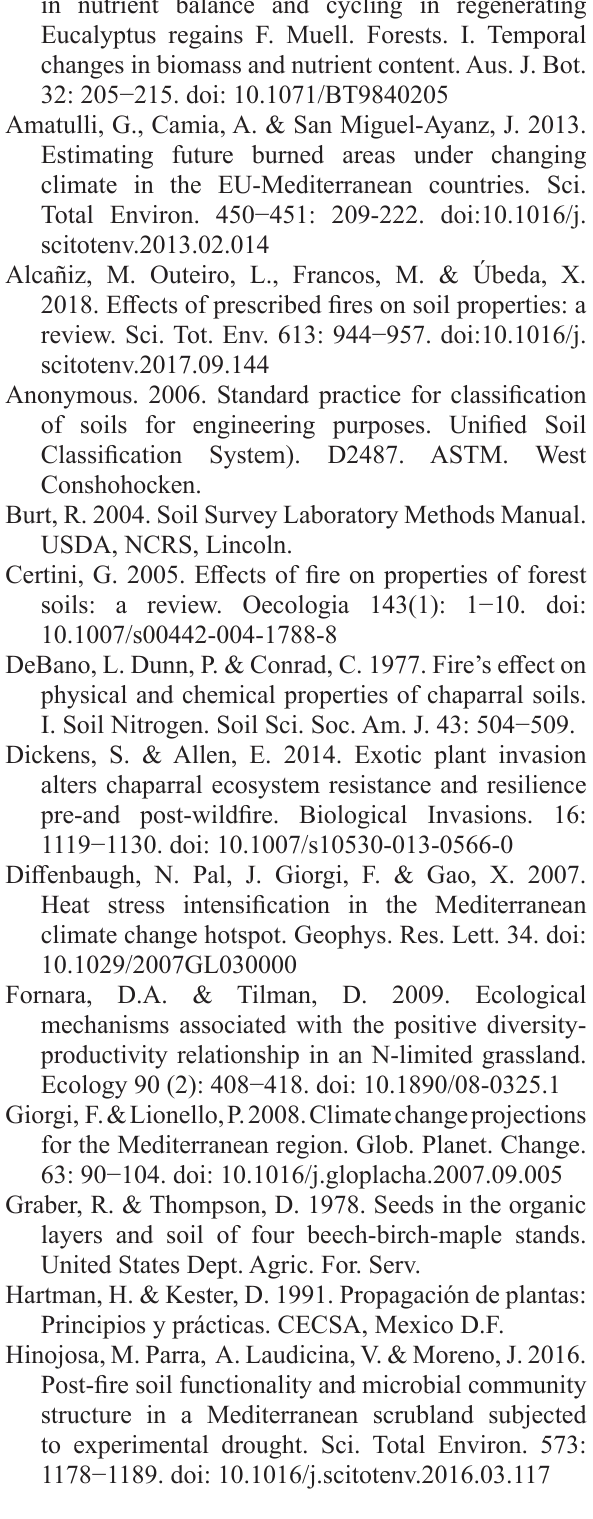
Table S1. Comparison of the proportion of the size fractions (%) of soil samples collected in the pilot-plots’ surroundings 5 and 7 years after wildfires (2015 and 2017). Table S2. Geographic coordinates and details of the permanent pilot-plots established in the